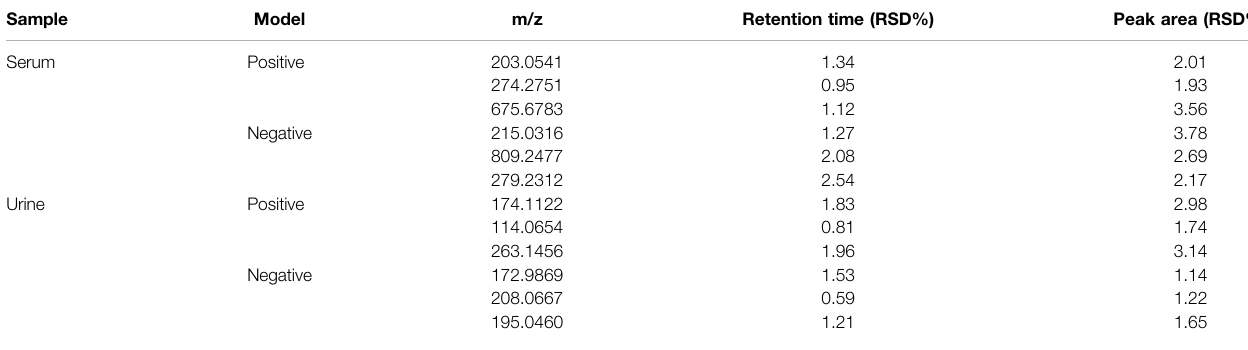
TABLE 1 | Relative standard deviation (RSD%) of retention time and peak area in QC samples. Sample Model m/z